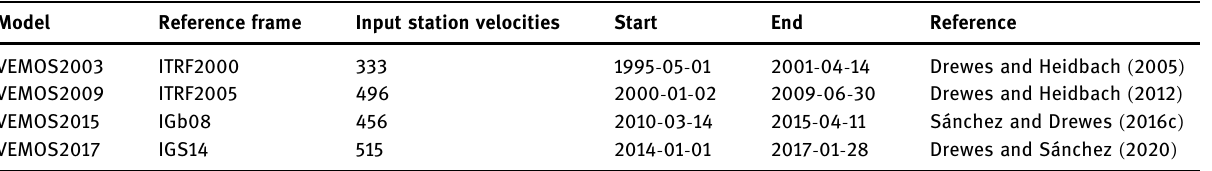
Table 6: Surface kinematics models VEMOS